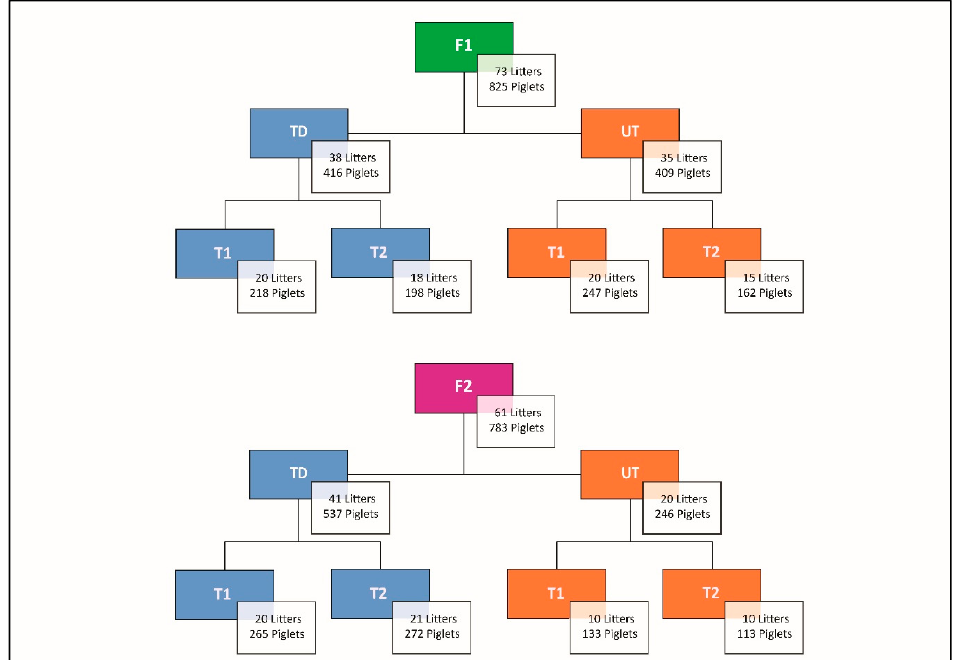
Figure 1. Scheme of observations. In the study, a total of 134 litters (1608 piglets) were assessed on two farms (F1, F2). The piglets on each farm were assessed on two different age (T1 = 7 days; T2 = 20 days of age). On each farm, there were litters with undocked (UT) and docked tails (TD). Tail docking was performed without local anaesthesia within the first week of life.